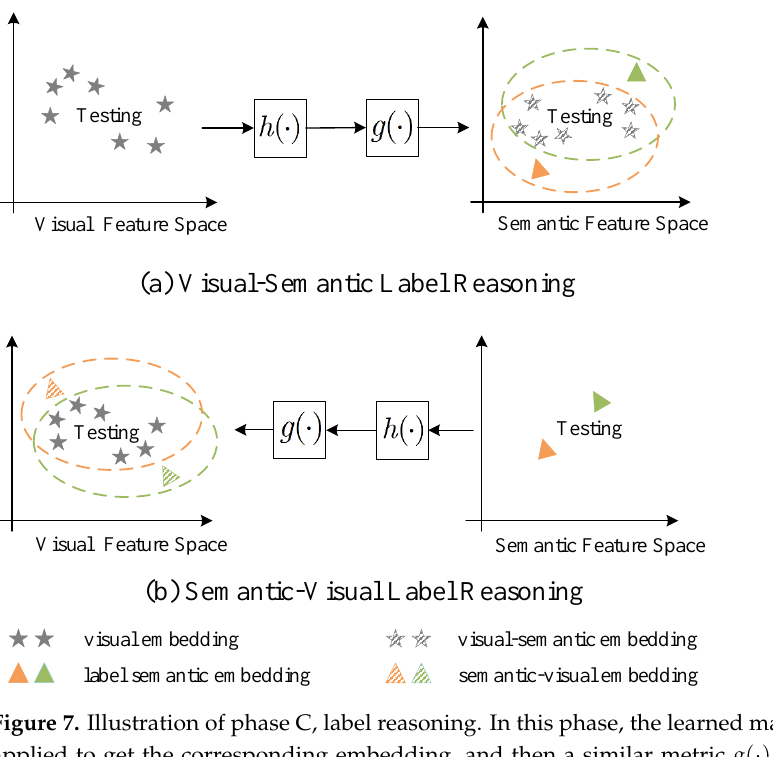
Figure 7. Illustration of phase C, label reasoning. In this phase, the learned mapping h ( · ) is firstly applied to get the corresponding embedding, and then a similar metric g ( · ) is employed in the selected feature space to find the final label.